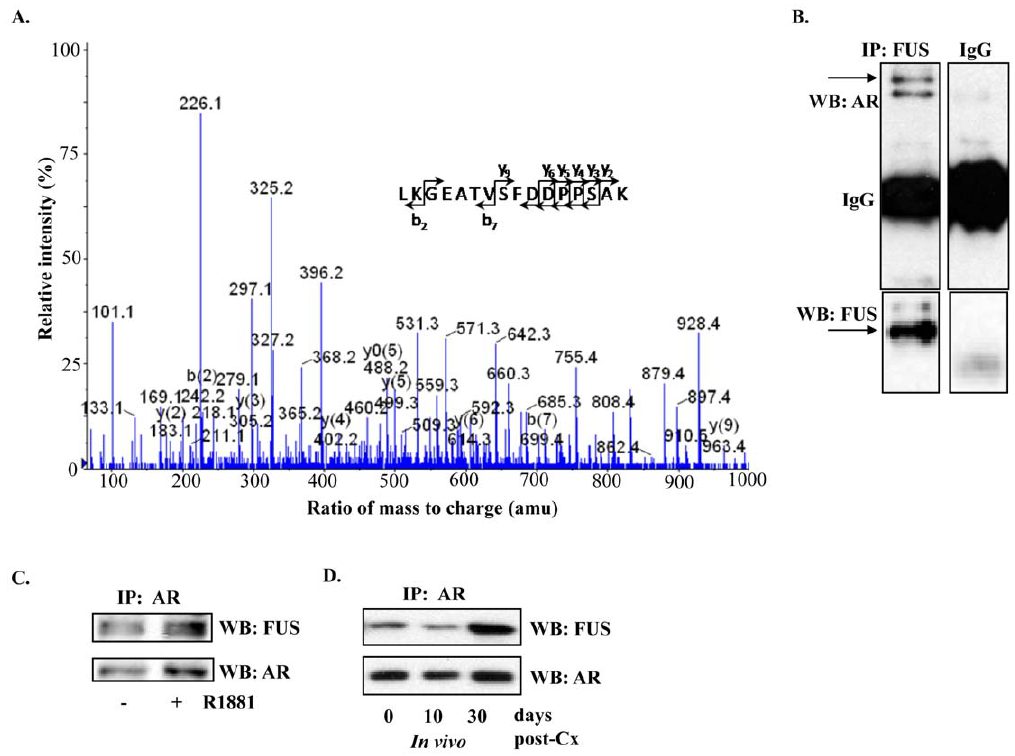
Figure 1. AR and FUS are found in the same complex in LNCaP cells. ( A ) Identification of FUS as an AR-interacting protein by co- immunopreciptation (Co-IP) followed by mass spectrometry (MS). MS/MS spectra of m/z 1660.77 (from 831.39, 2 + ) of FUS and two others shown in supplementary material were unambiguously assigned the identified sequence LKGEATVSFDDPPSAK, APKPDGPGGGPGGSHMGGNYGDDR, and TGQPMINLYTDR, respectively. ( B ) Validation of AR-FUS interaction using Co-IP followed by western blot analysis. LNCaP cells in culture were induced with 10 nM R1881 for 6 hrs and whole lysates were used for IP with anti-FUS antibody followed by anti-AR western blot (WB) analysis. ( C ) Reverse IP with anti-AR followed by WB with anti-FUS antibody. ( D ) IP of endogenous complexes of AR and FUS from subcutaneous LNCaP xenografts. Tumours were harvested from intact mice (I), 10 days after castration (C10) or 30 days after castration (C30). Lysates from these tumors were individually used for IP with anti-AR antibody followed by WB with indicated antibodies.